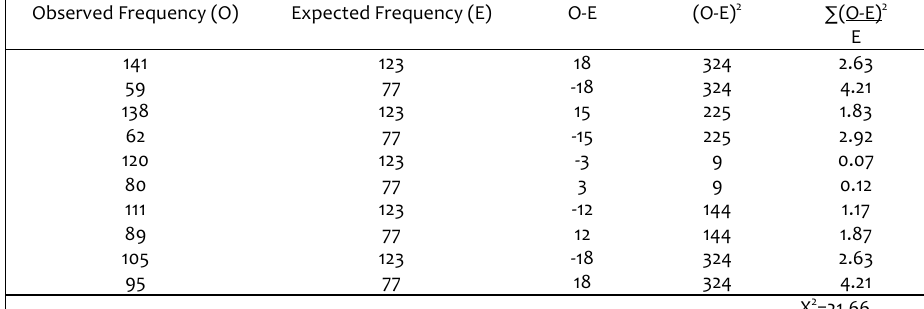
Figure 9: Calculation of chi ‐ square for hypothesis 4